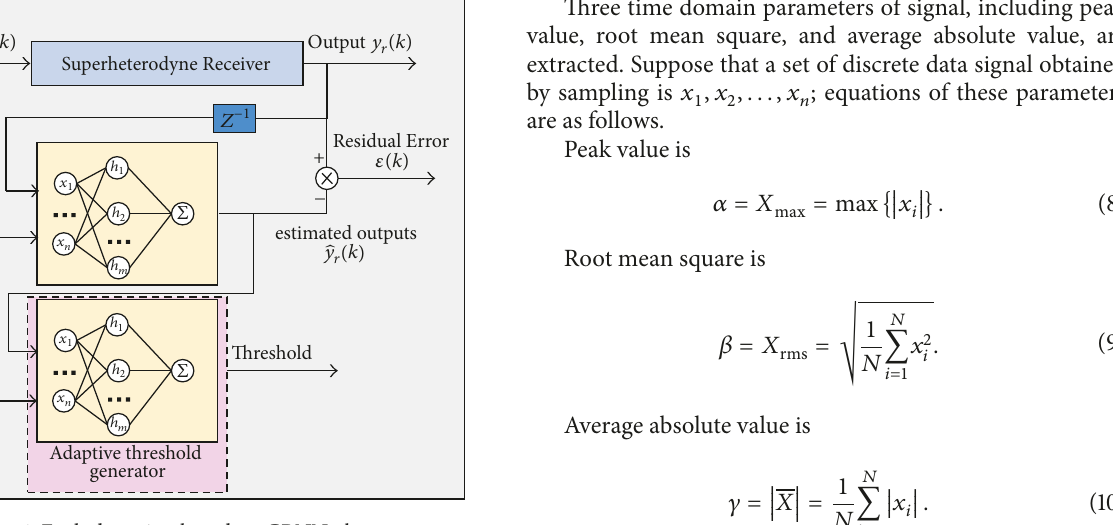
Figure 4: Fault detection based on GRNN